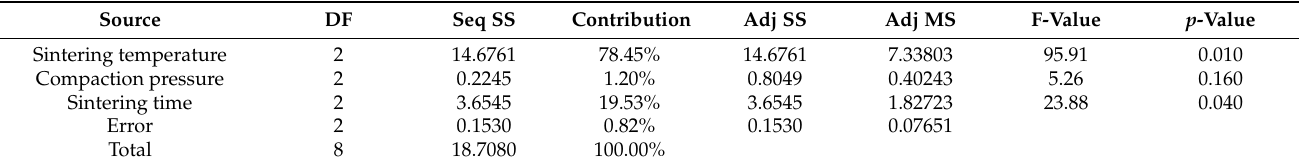
Table 7. ANOVA Variance table for energy absorption